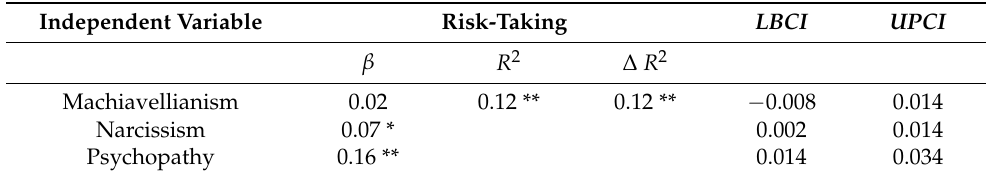
Table 2. Hierarchical linear regression on the predictive power of the Dark Triad traits on risk-taking at work.